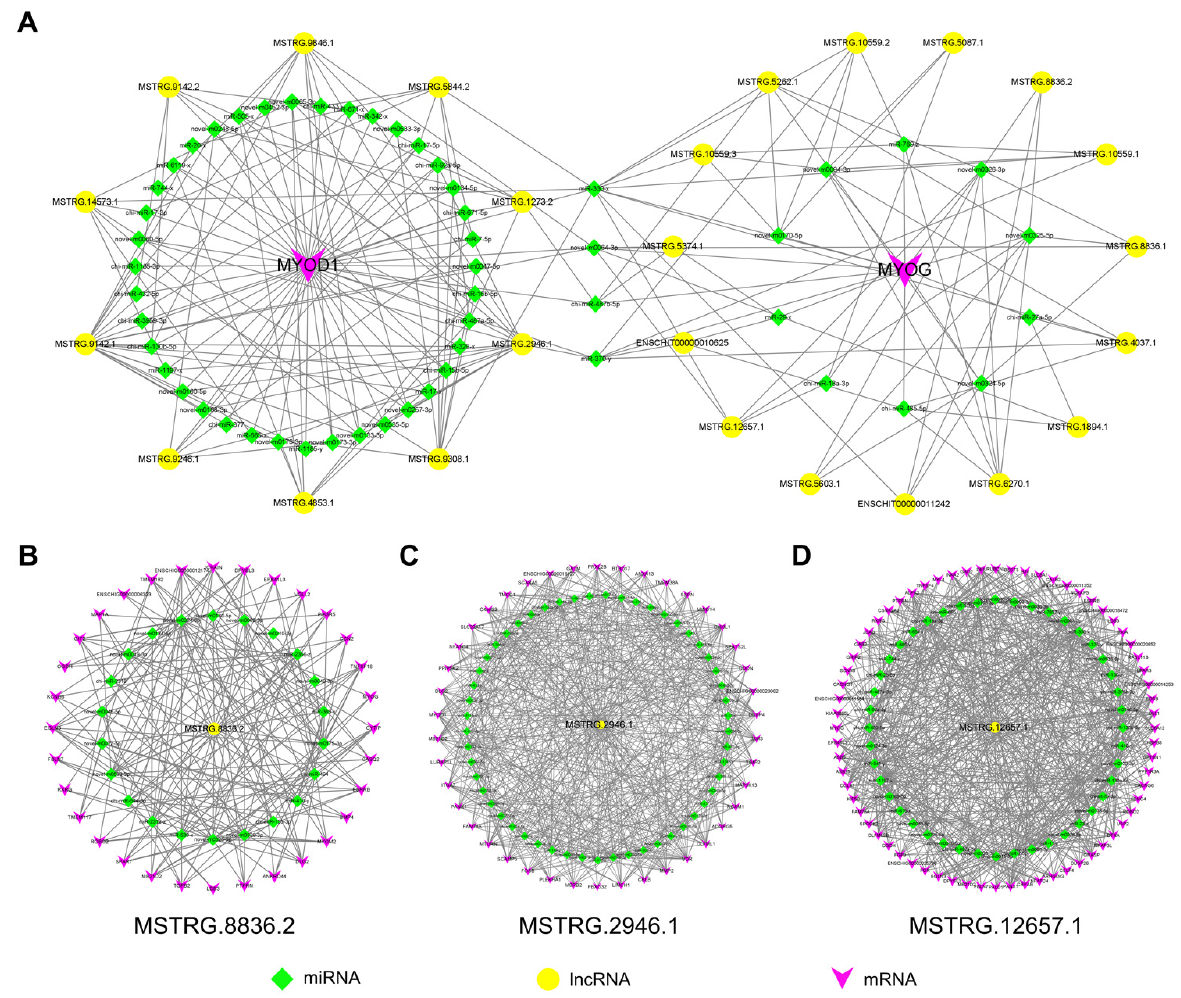
Figure 7. The ceRNA networks. ( A ) CeRNA networks associated with MyoD and MyoG. ( B – D ) CeRNA networks for MSTRG.8836.2, MSTRG.2946.1, and MSTRG.12657.1. DE lncRNAs and mRNAs, as well as their common target miRNAs were used to establish the ceRNA networks. In these networks, genes are displayed in purple arrow, lncRNAs are displayed in yellow circle, and miRNAs are indicated with green diamond pa tt erns.